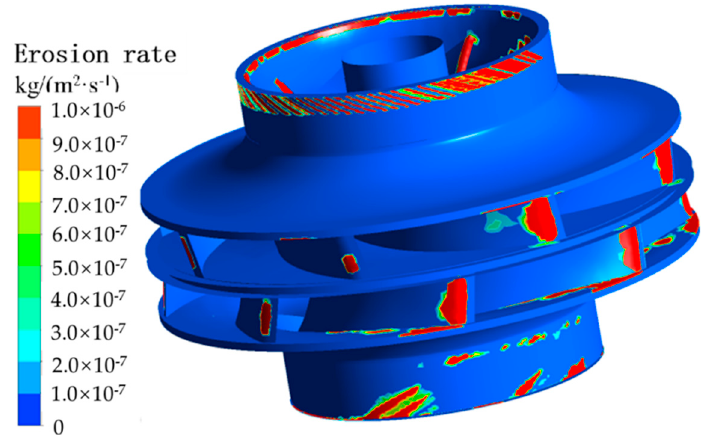
Figure 7. Distribution of erosion rate (CFD).